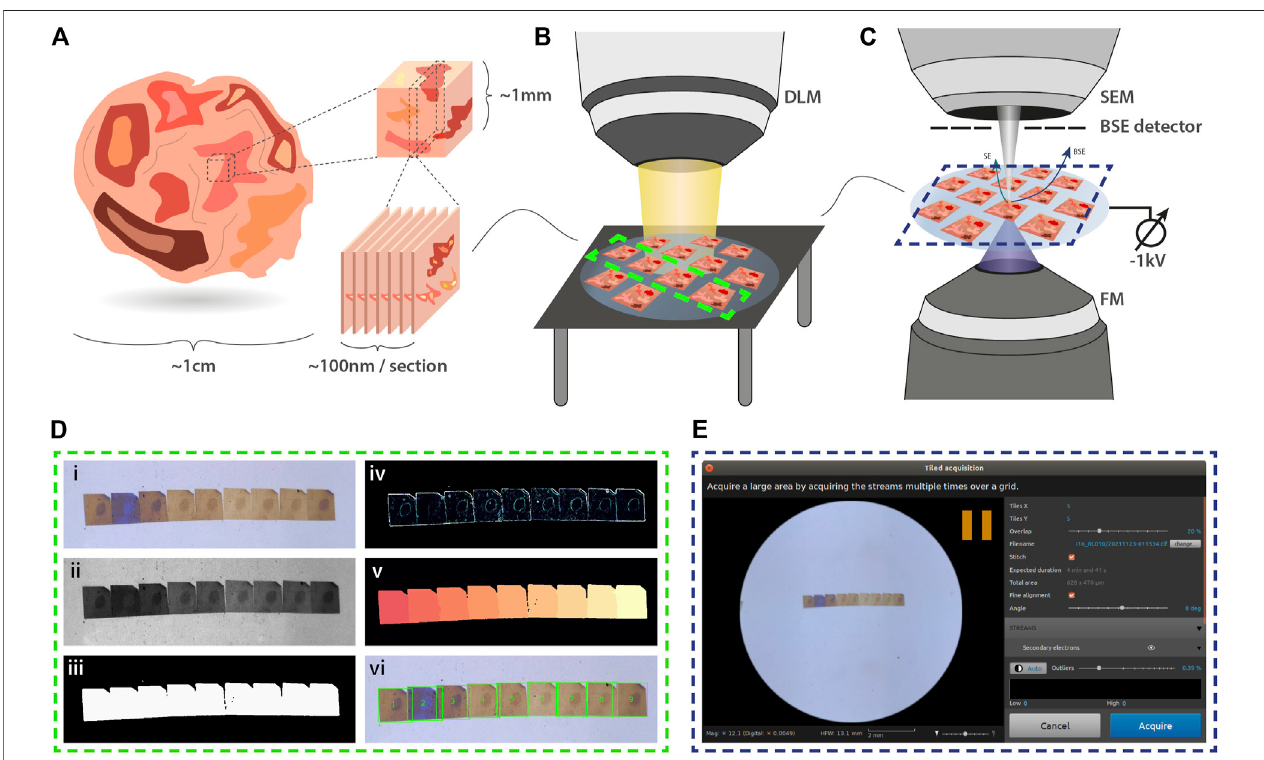
FIGURE 1 | Integrated array tomography. (A) Ultrathin sections are prepared for simultaneous FM and EM imaging. (B) An overview image of the sections on the ITO-coated glass slide is then acquired by a digital light microscope (DLM). (C) Next, the sample is transferred to the integrated microscope for CLEM imaging. SEM imaging is performed using a − 1kV bias potential applied to the sample stage to enhance BSE collection from the non-post-stained sections. (D) The overview image obtained by the DLM is used for instance segmentation of the serial sections. Descriptions of the image processing steps (i-vi) is provided in the main text. (E) The section overview image and bounding box coordinates of each serial section are fed to the microscope software to facilitate